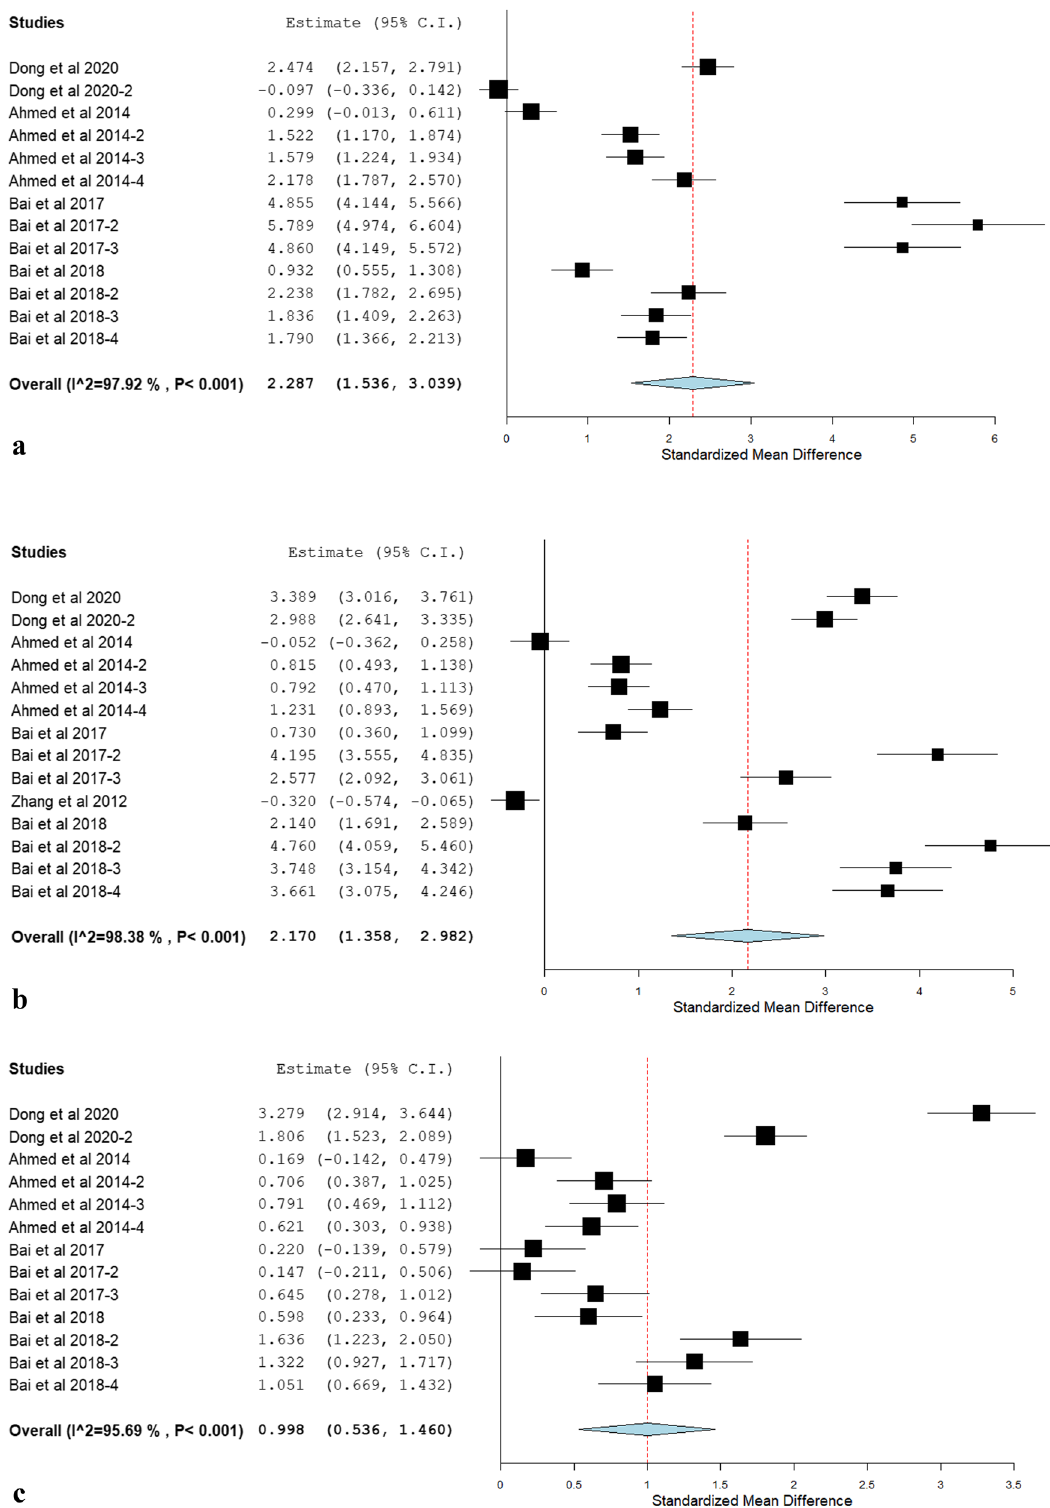
Figure 3: Forest plots of the e ff ect of diets with or without Bacillus supplement on blood ( a ) IgA; ( b ) IgG and ( c ) IgM in broiler chickens. The x - axis shows the di ff erence between diets with or without Bacillus supplements. The points to the left of the line represent a reduction in the trait, while the points to the right of the line indicate an increase. Each square represents the size of the mean e ff ect of that study, and the size of the square re fl ects the relative weight of the study of the overall estimate of e ff ect size with the larger squares representing a larger weight. The upper and lower bound of the squared line represents the upper and lower con fi dence intervals ( CIs ) of 95% for the size of the e ff ect. The diamond at the bottom represents the 95% CI for the global estimate, and the vertical line of points represents the mean di ff erence of zero or no e ff